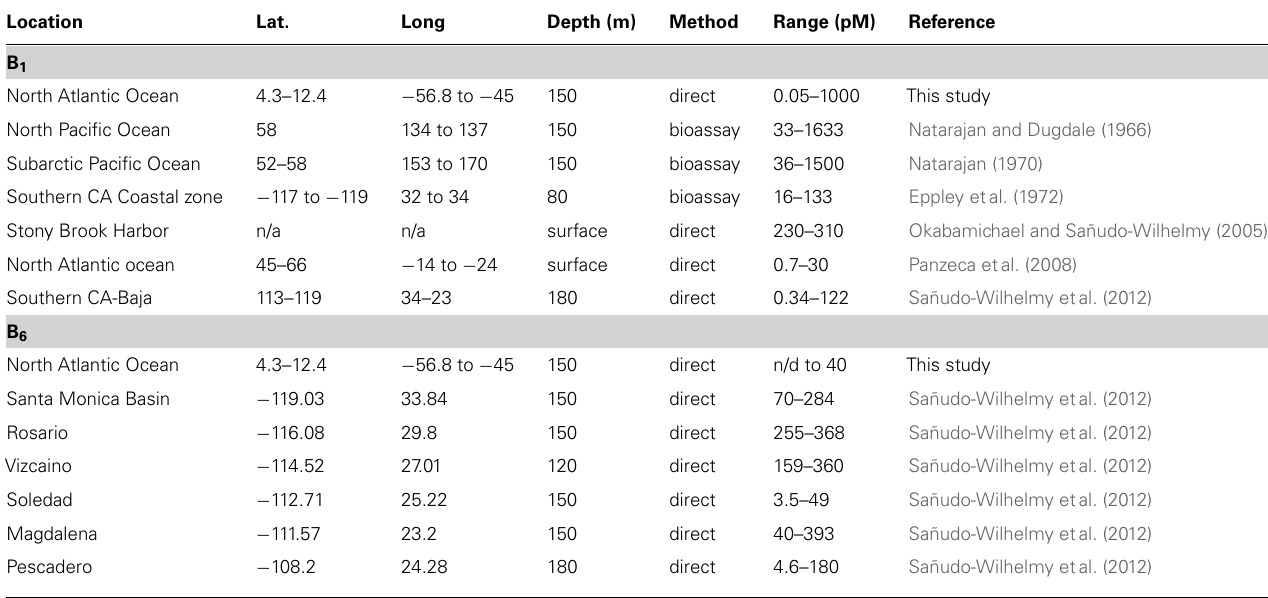
Table 4 | Global B vitamin concentrations including current and previous studies. n/a not available, n/d not detectable.